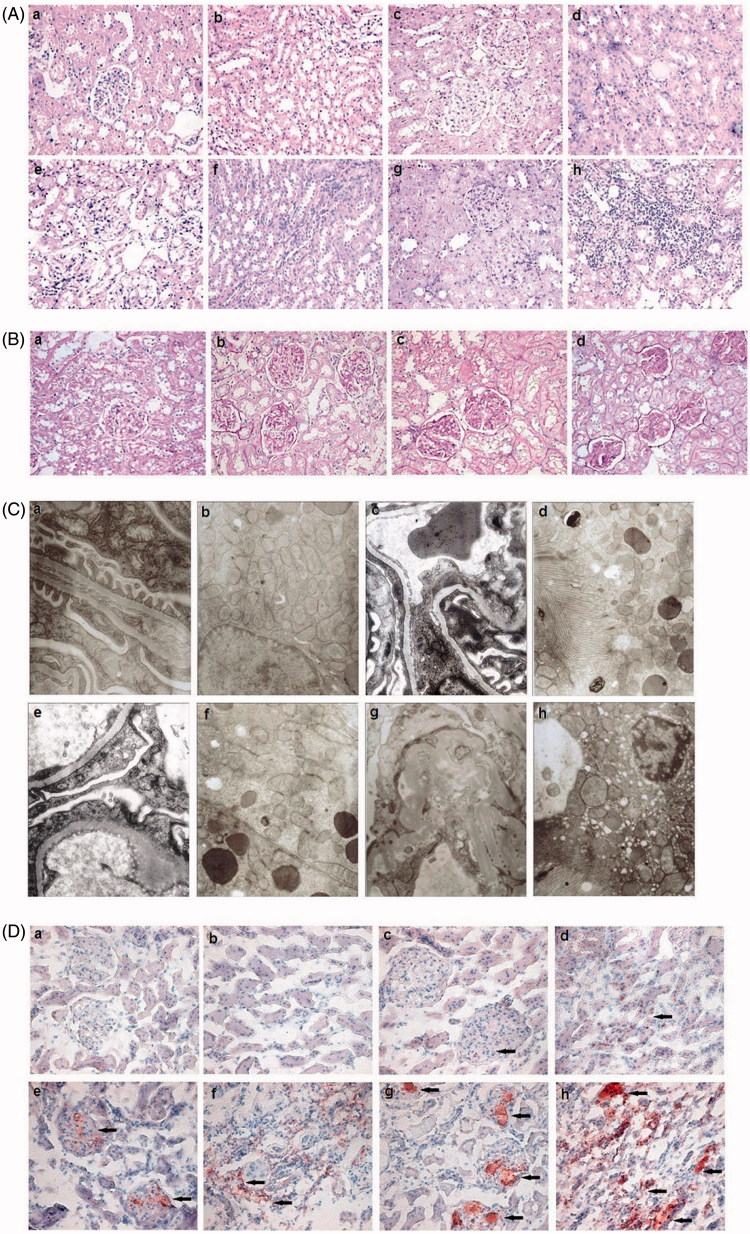
Pathological changes in renal tissue. (A) HE staining of the glomeruli and tubules in Group N (a and b), HF (c and d), ADR (e and f), ADR + HF (g and h), (400×). (B) PAS staining of the glomeruli in Group N (a), HF (b), ADR (c), ADR + HF (d), (400×). (C) The ultrastructure of the glomeruli and tubules detected by electron microscopy, in Group N (a and b), HF (c and d), ADR (e and f), ADR + HF (g and h) (Glomeruli EM 14,000×, Renal tubules EM 7000×). (D) Sudan III staining of glomeruli and tubules in Group N (a and b), HF (c and d), ADR (e and f), ADR + HF (g and h), (400×). Immunocytochemistry showed no fat expression in the kidneys of Group N, little fat expression in the tubular epithelium of Group HF, more fat expression in the epithelium of glomeruli and renal tubules in Group ADR, Strong fat expression in glomeruli and renal tubules in Group ADR + HF (arrowheads).